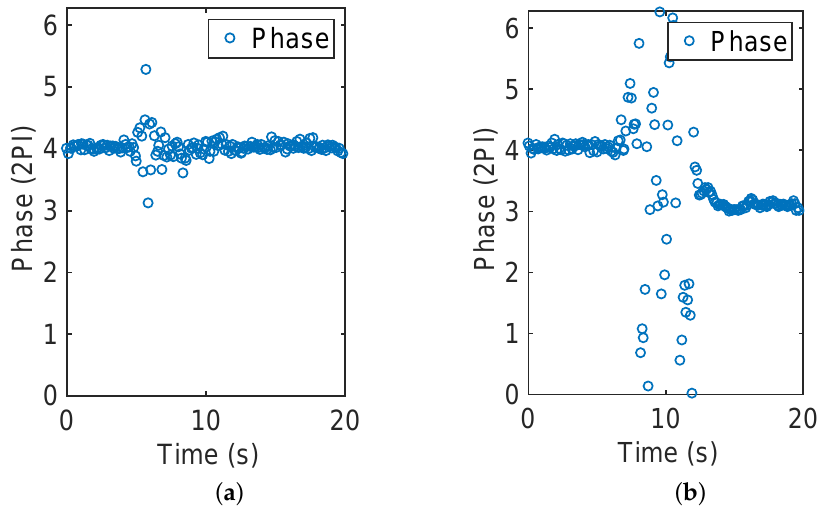
Figure 3. Interactions and the corresponding phase changes. ( a ) Passing by; ( b ) Picking